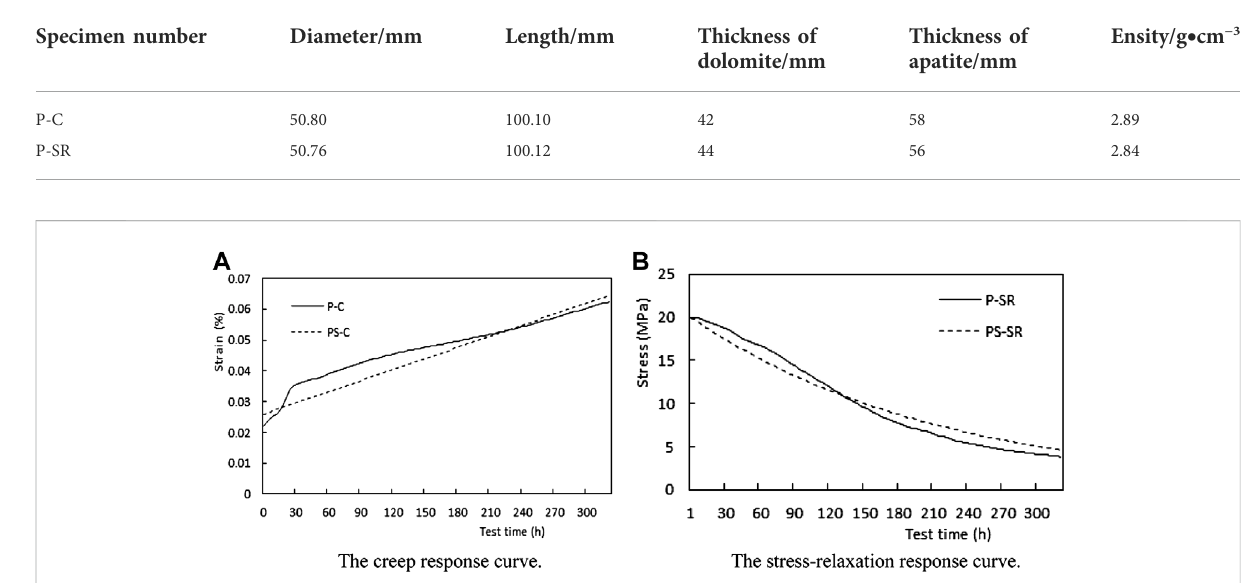
FIGURE 7 Graphical plot of the veri fi cation-test results (test versus simulation). (A) The creep response curve. (B) The stress-relaxation response